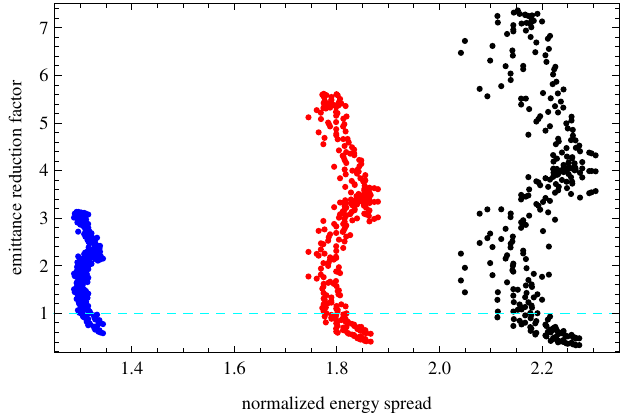
FIG. 7. Relative increases in beam energy spread for the optimal solutions in Fig. 1, using the same color scheme for the maximum field strength 2 (blue), 4 (red), and 6 (black). For each solution, three dots are plotted corresponding to the emit- tance reduction factors for AME, TME, and EME. (We choose not to use different markers for different lattices to avoid over- lapping. However, from Fig. 2, it is clear that the upper branch is from TME